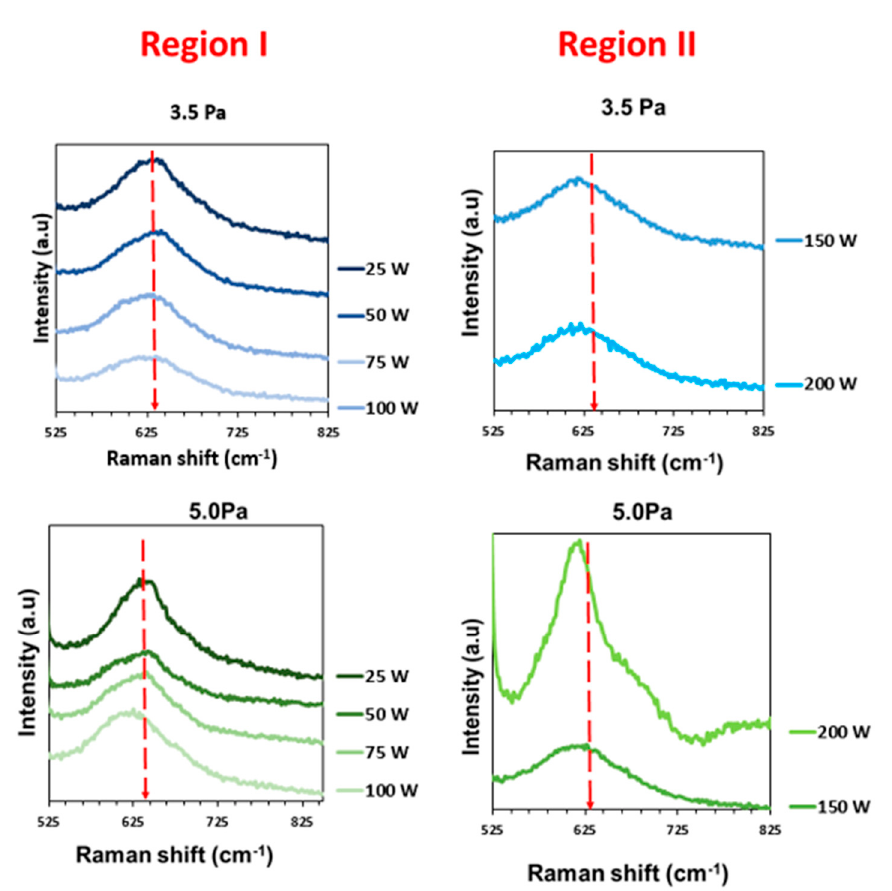
Figure 6. The Raman spectra of Cu 3 N films prepared at different RF powers and gas pressures of 3.5 Pa and 5.0 Pa. (25–100 W, region I, and 150–200 W, region II).